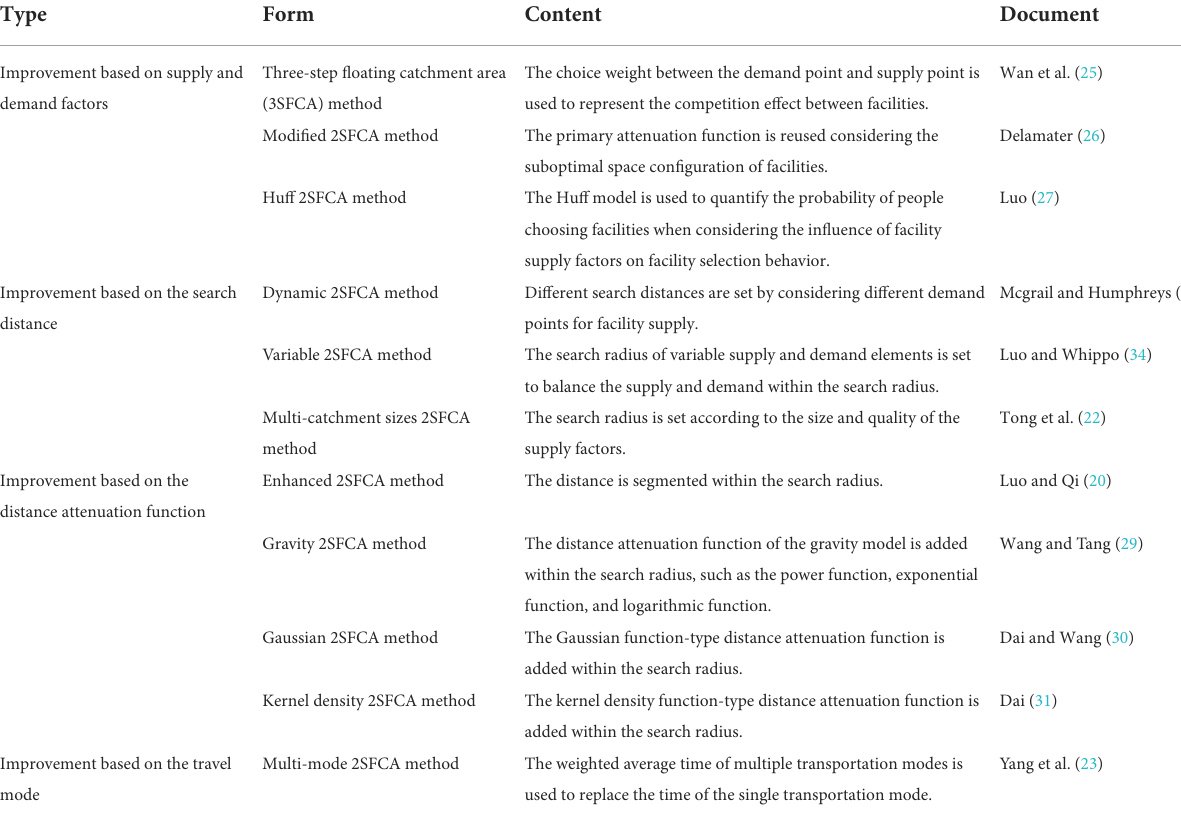
TABLE 1 Main extensions of the Gaussian two-step floating catchment area (2SFCA)